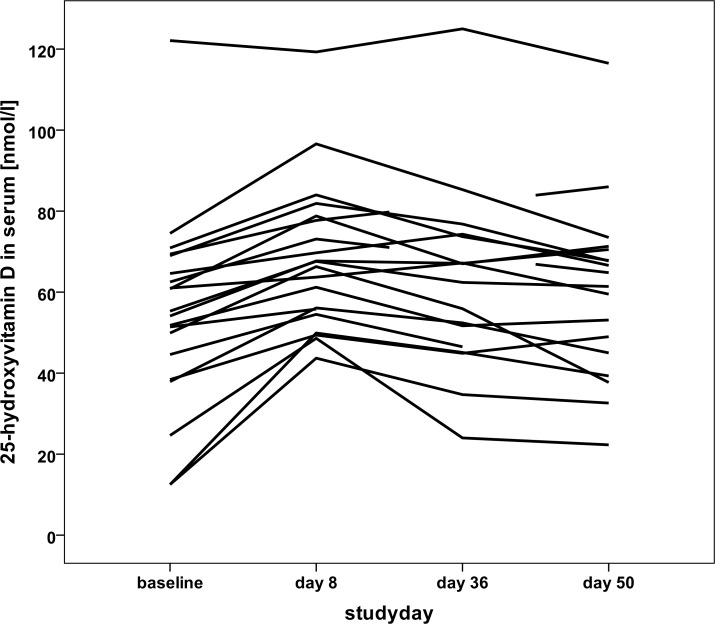
Individual Vitamin D status as expressed by 25-hydroxyvitamin D concentration in plasma during the study.